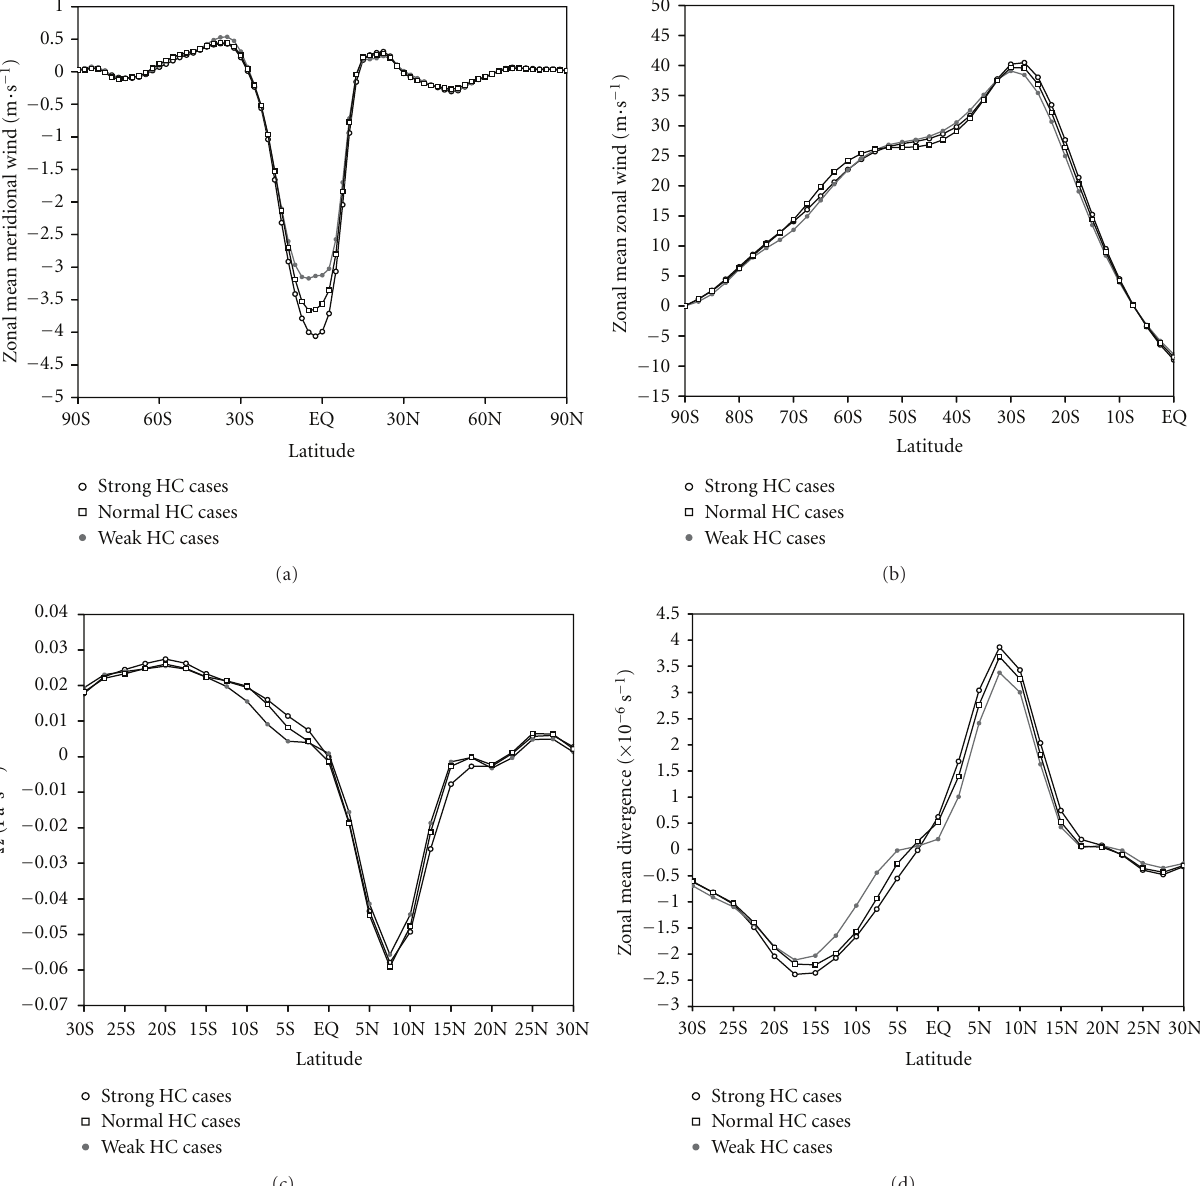
in JJA is intense over Eastern Equatorial Pacific, near Central America, and around India, Thailand and Filipinas.